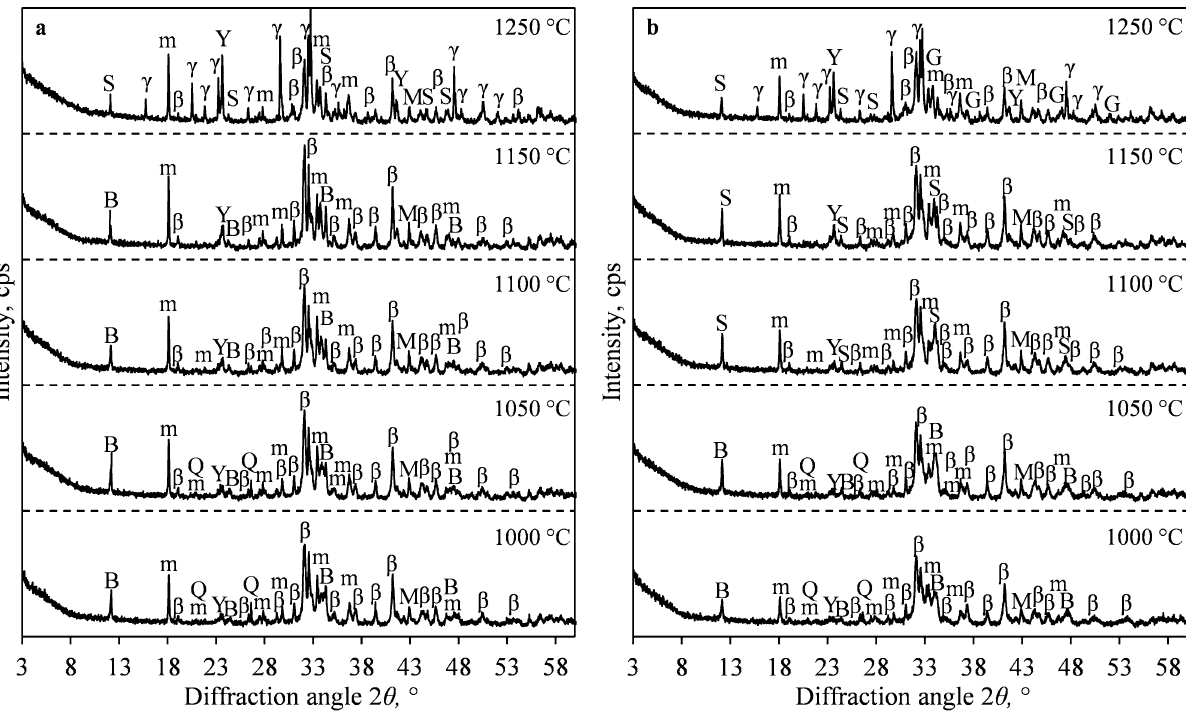
Figure 3. XRD patterns of S1 ( a ) and S2 ( b ) samples sintered at different temperatures. Indexes: Q-quartz; S-srebrodolskite; m-mayenite; β-larnite (β-C